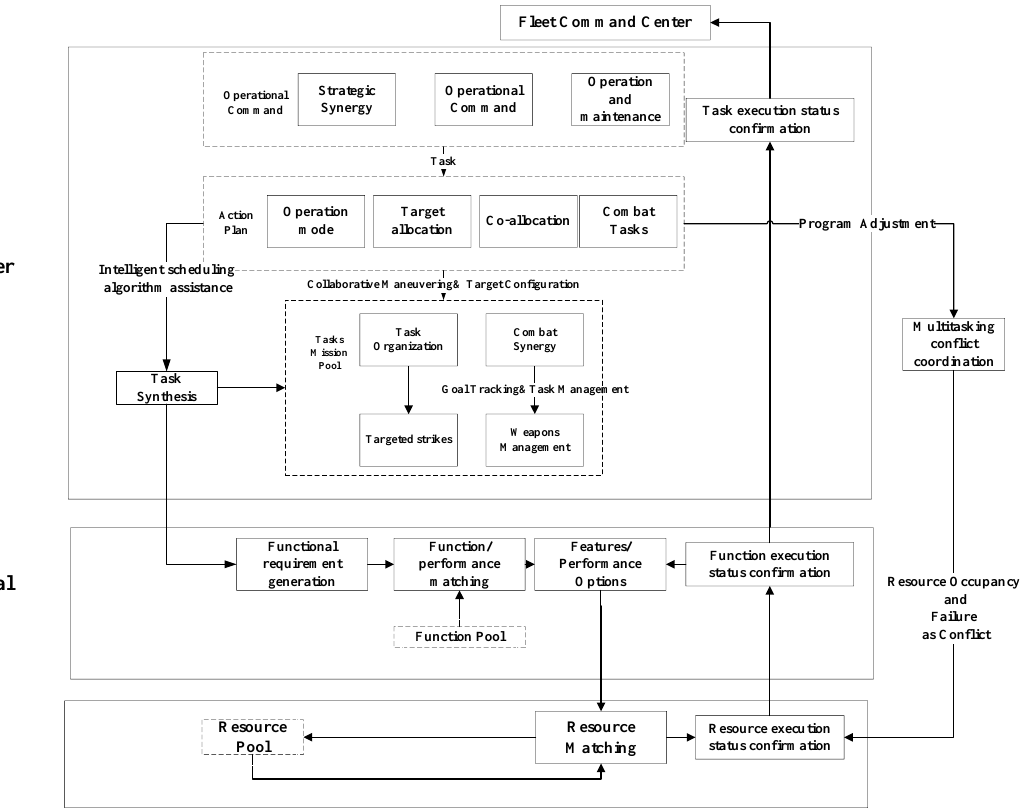
Figure 5. Joint fleet hierarchical logical architecture under Avionics Cloud architecture.